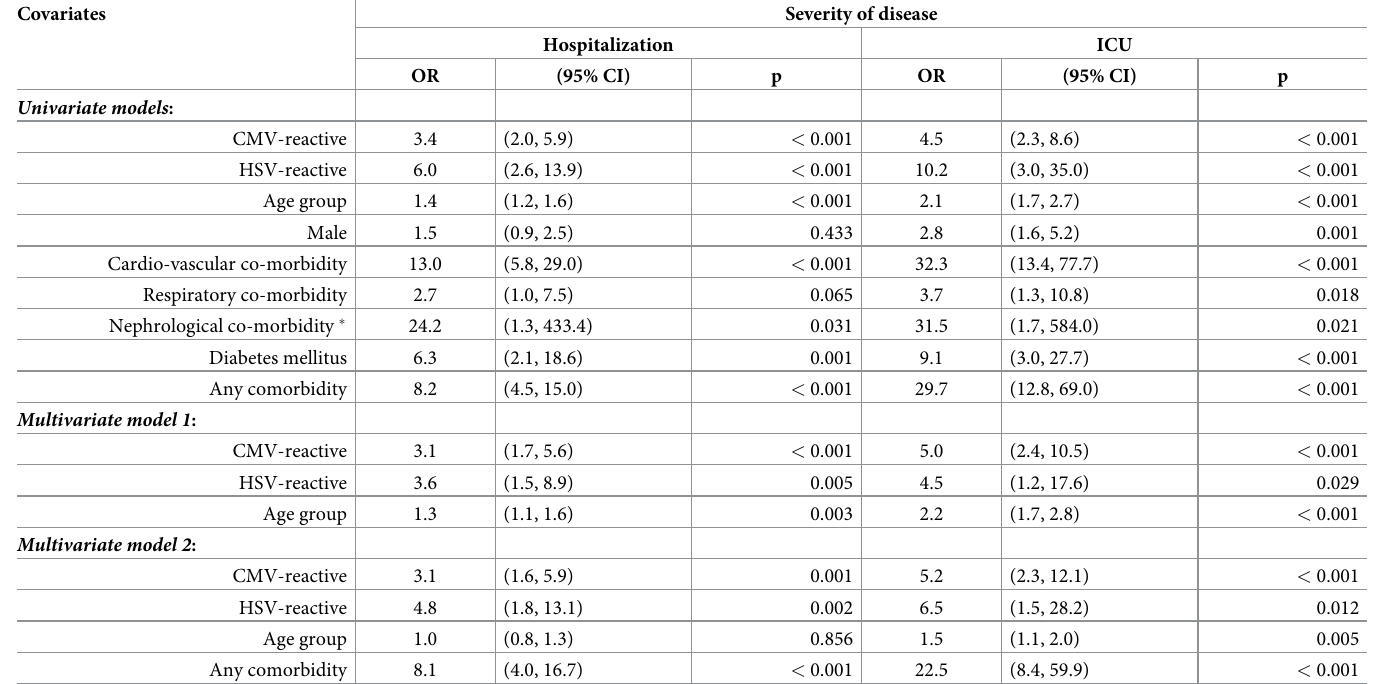
The reference category is: Mild disease. � Firth Penalized Likelihood correction in two separate binary logistic regression models due to quasi-complete separation of the data; Firth’s correction is not yet implemented for multinomial